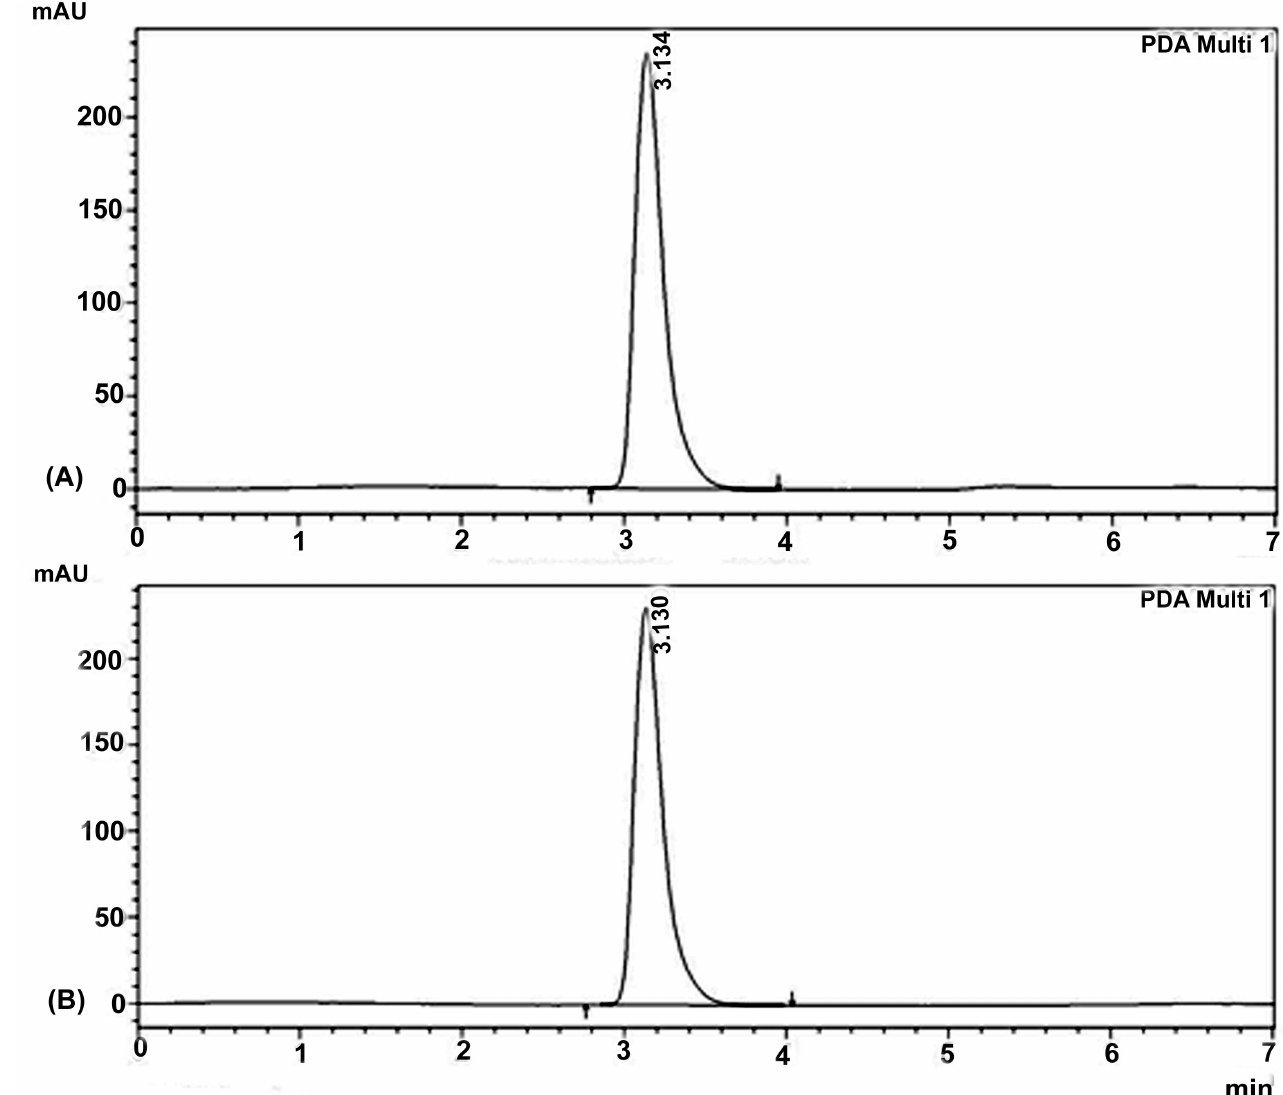
FIGURE 6 - Typical chromatograms of GLP standard drug (A) and GLP in injection formulation